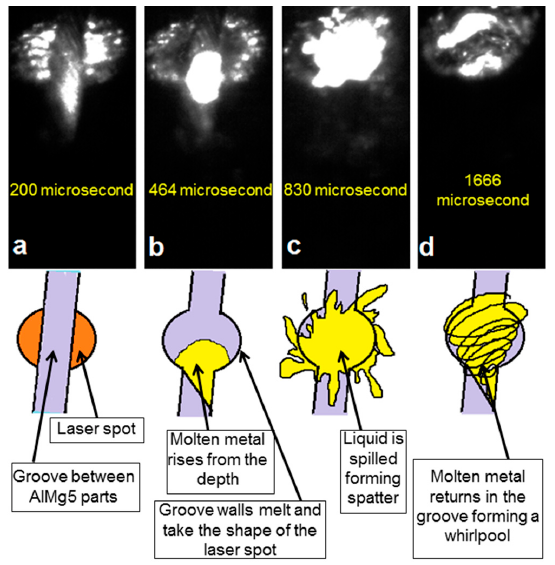
Figure 6. High-speed imaging of phenomena occurring during laser irradiation with a pulse of 5.5 kW power and 2 ms duration of the joint between two AlMg5 pieces: ( a ) metal reaches incandescence; ( b ) molten metal rises from the groove; ( c ) expulsion of liquid phase; ( d ) metal returns in the groove forming a whirlpool.